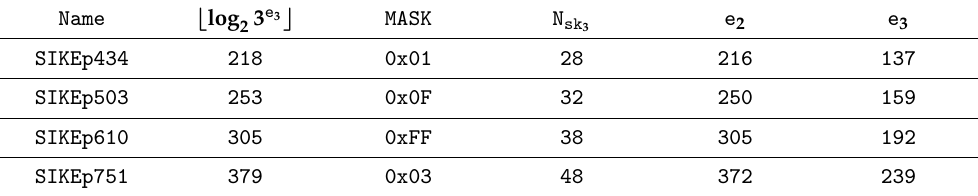
Table 1. Relevant constants from Supersingular Isogeny Key Encapsulation (SIKE)